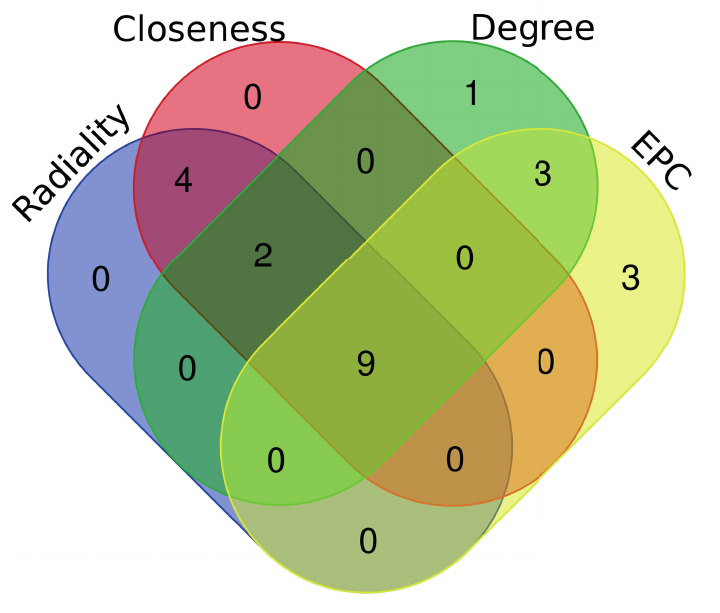
Figure 5 - Nine Hub genes were identifi ed by four methods of